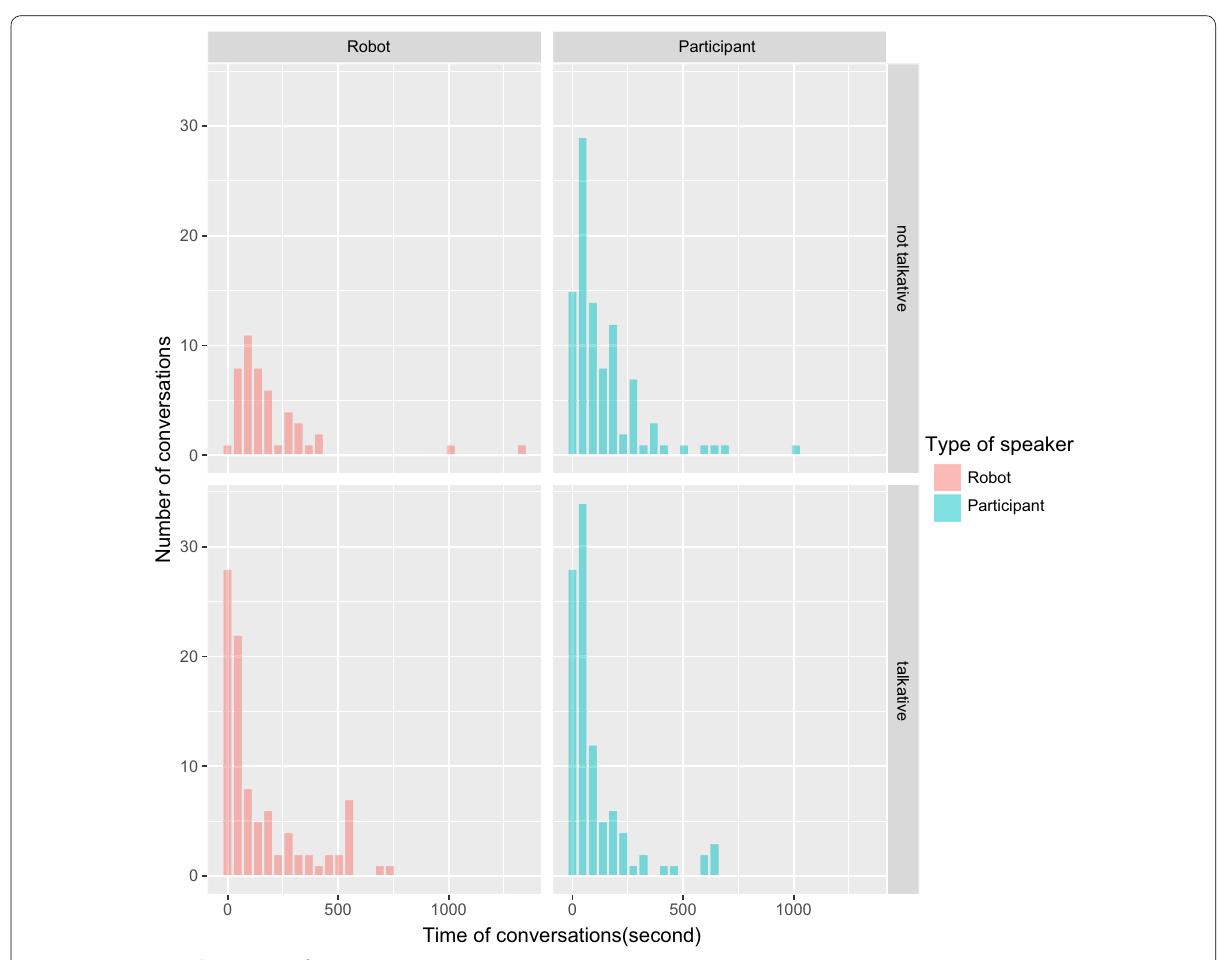
Fig. 7 Summarizing the amount of